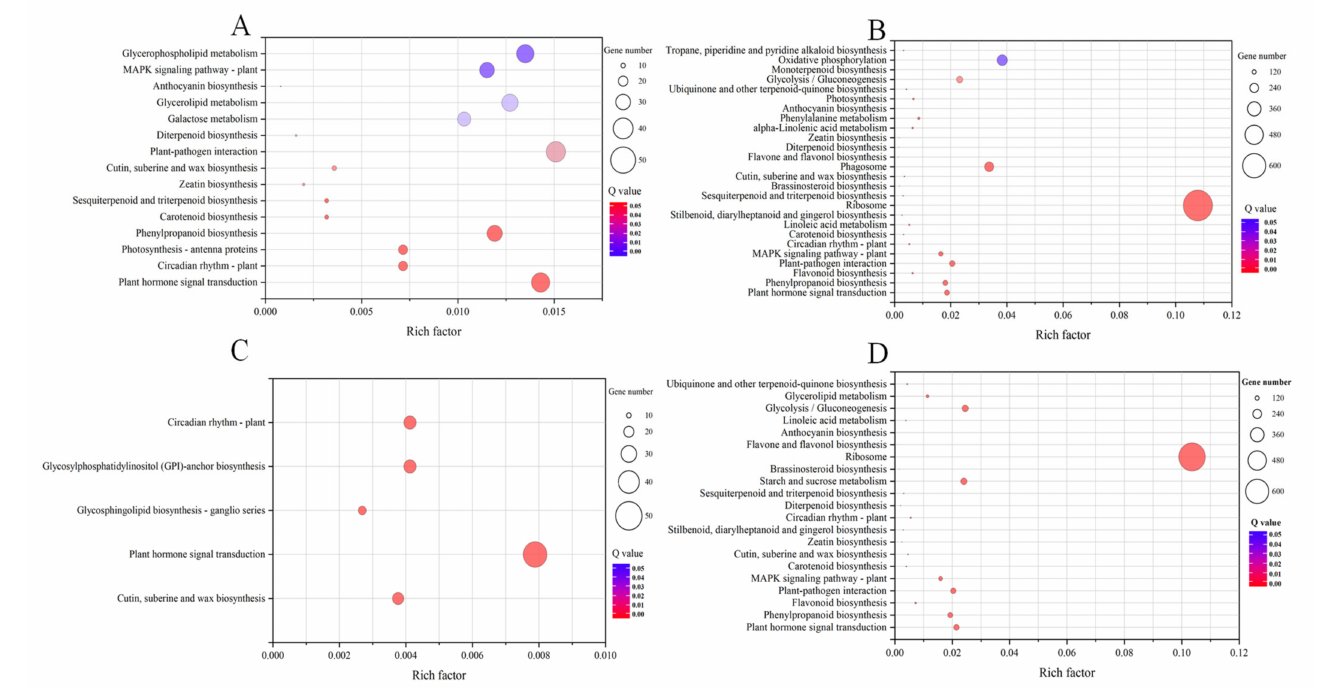
Figure 5. Statistics analysis of Kyoto Encyclopedia of Genes and Genomes (KEGG) enrichment among different groups in Myriophyllum aquaticum ), leaf and root from low phosphorus concentration treatment ( A , B ); leaf and root from high phosphorus concentration treatment ( C , D